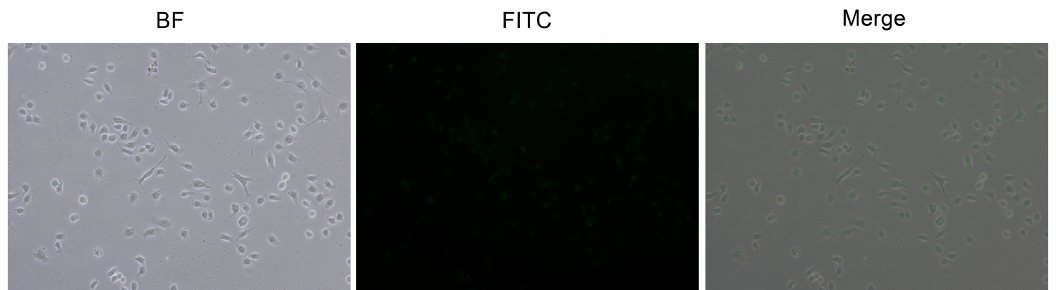
Figure 9. The uptake and localization of mPEG-PAMAM G5.NH 2 -FITC in HepG2 cells. The cellular uptake of dendrimer nanocomposites exhibited strong fluorescence in the cytoplasm and nucleus.